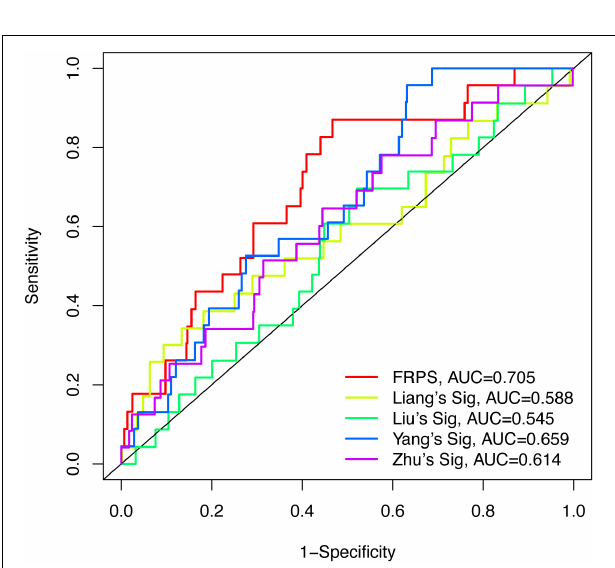
and 17 genes were correlated with overall survival ( Table 1